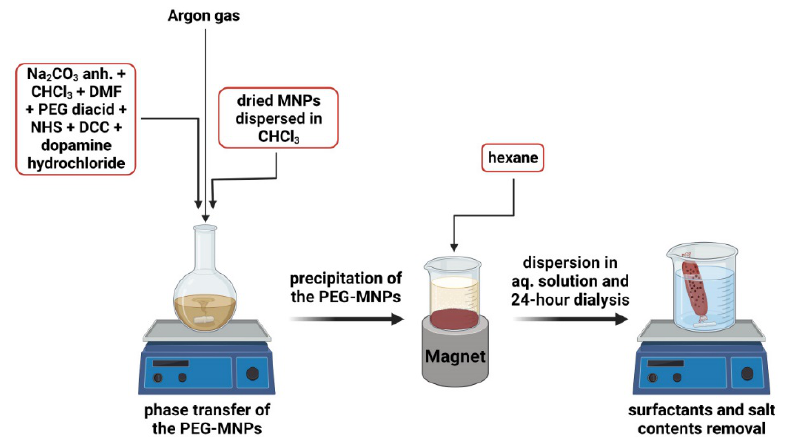
Figure 2. Schematic illustration describing the principle of the MNPs polymer coating process. Image “Created with BioRender.com”.